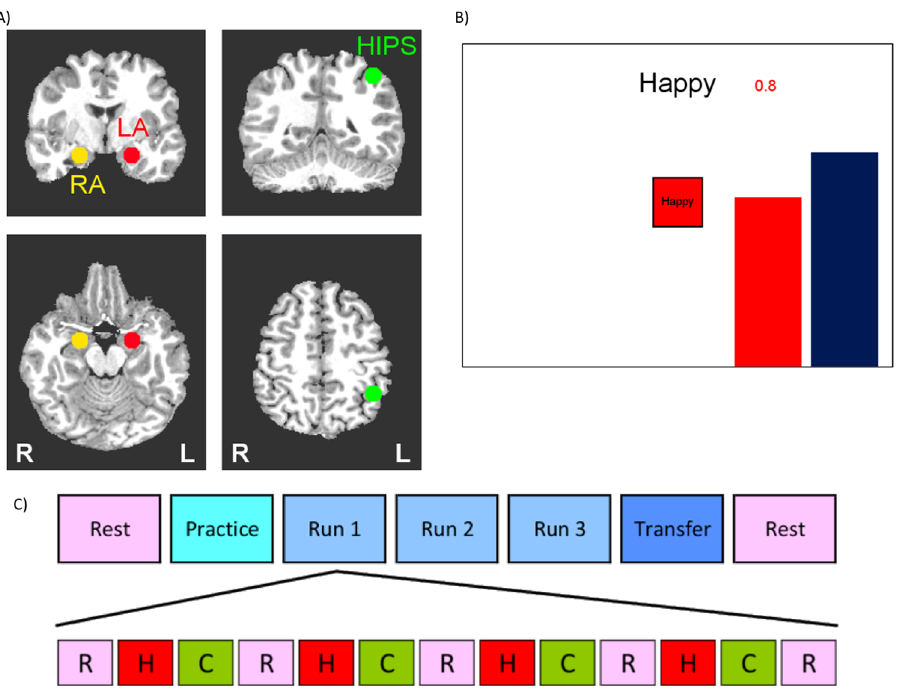
Figure 1. Design of the rtfMRI neurofeedback experiment. A) Regions of Interest (ROI) for the rtfMRI neurofeedback procedure. Three regions of interest (spheres of 7 mm radius) were used to assess changes in BOLD activity. These regions were the left amygdala (LA, red, centered at -21, -5, -16), right amygdala (RA, yellow, centered at 21, -5, -16), and left horizontal segment of the intraparietal sulcus (HIPS, green, centered at -42, -48, 48). ROI placements are illustrated on T1-weighted coronal (upper row) and axial (lower row) human brain sections in Talairach space[48]. Following radiological notation, the left side (L) of the brain is shown on the right, and the right side (R) of the brain on the left. B) Real- time display screen for the rtfMRI neurofeedback procedure. During the Happy condition, the word ‘‘Happy,’’ two color bars, and a number indicating the neurofeedback signal were displayed on the screen. Participants were instructed to recall happy autobiographical memories to make themselves feel happy while trying to increase the level of the red bar representing the feedback signal from the target ROI to a given target level indicated by the fixed height of the blue bar (but not to exceed that target level). C) Protocol for the rtfMRI neurofeedback experiment. The experimental protocol consisted of seven runs each lasting 8 min 40 sec. During the Rest runs, participants were instructed to rest with their eyes open. During the Practice run, the participants were given the opportunity to become comfortable with the procedure and test out different memories. During Runs 1–3 participants underwent rtfMRI neurofeedback training consisting of alternating blocs of Rest (R, pink block), Happy (H, red block), and Count (C, green block, instructed to count backwards from 300 by a given integer), each lasting 40 sec. During the Transfer Run, participants were instructed to perform the same task as during the neurofeedback training, but no neurofeedback information (bars, numbers) was provided.